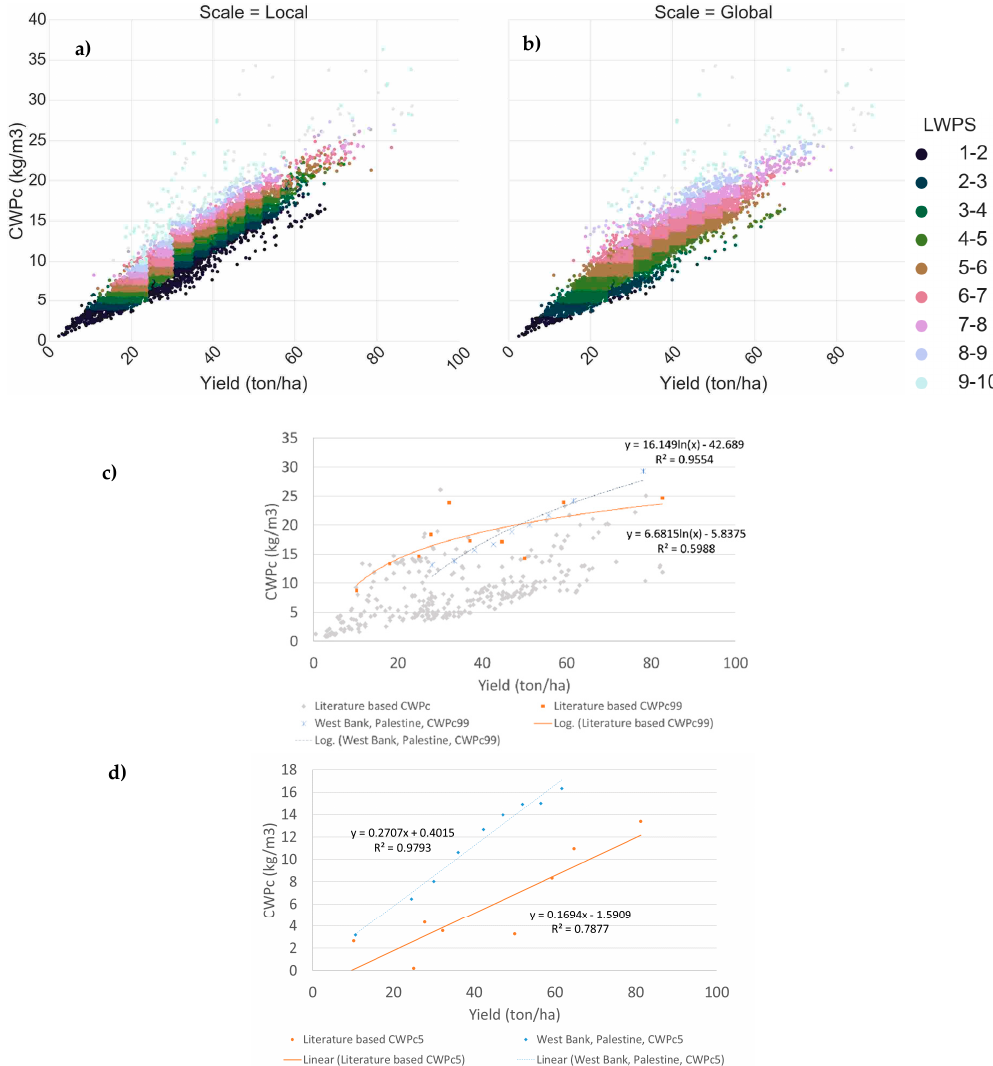
Figure 7. CWPc plotted against yield identifying score clusters for the local water productivity score (LWPS) for ( a ) local Palestinian targets and ( b ) based on global literature values as targets and the associated upper ( c ) and lower ( d ) boundary functions of potato CWP in West Bank, Palestine and based on global literature